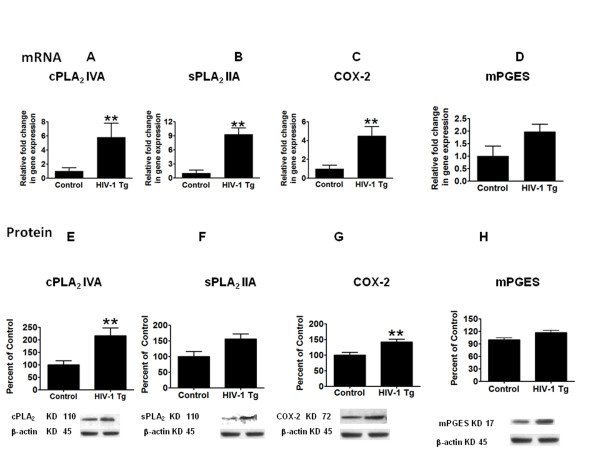
mRNA levels of brain cPLA2-VIA (A), sPLA2-II (B), COX-2 (C), and mPGES (D) in control and HIV-1 Tg rats, determined using real time TaqMan RT-PCR. Data are levels of brain cPLA2-VIA, sPLA2-II, COX-2 and mPGES in the HIV-1 Tg rat normalized to the endogenous control (β-globulin) and relative to control level (calibrator) using the ΔΔCT method. Representative immunoblots of (E) cPLA2-VIA, (F) sPLA2- IIA (G) COX-2, and (H) mPGES protein in control and HIV-1 Tg rats. Bar graphs represent ratios of optical densities of each individual protein band relative to β-actin, expressed as percent of control mean ± SEM. Mean ± SEM. Data were analyzed by individual unpaired t-tests, statistical significance: **p < 0.01, ***p < 0.001.